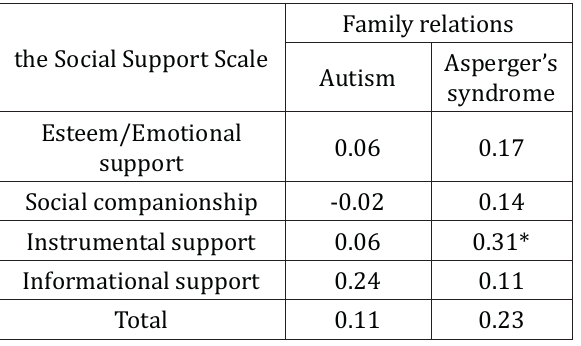
Table 6. Correlation coefficients calculated between the assessment of family relations and the Social Support Scale in the group of mothers of children with autism and with Asperger's syndrome